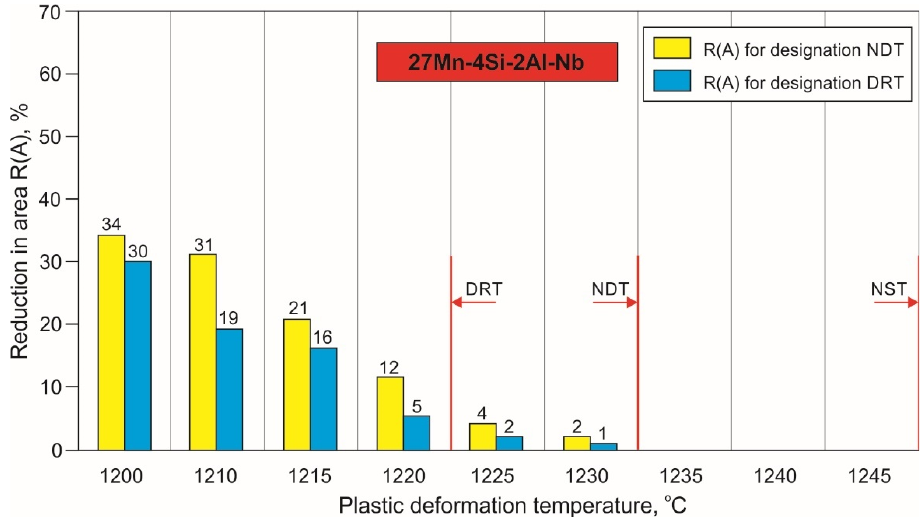
Figure 8. Influence of plastic deformation temperature on the reduction in area R(A) of samples of 27Mn-4Si-2Al-Nb steel after tensile force according to the scheme shown in Figures 2a and 3a.